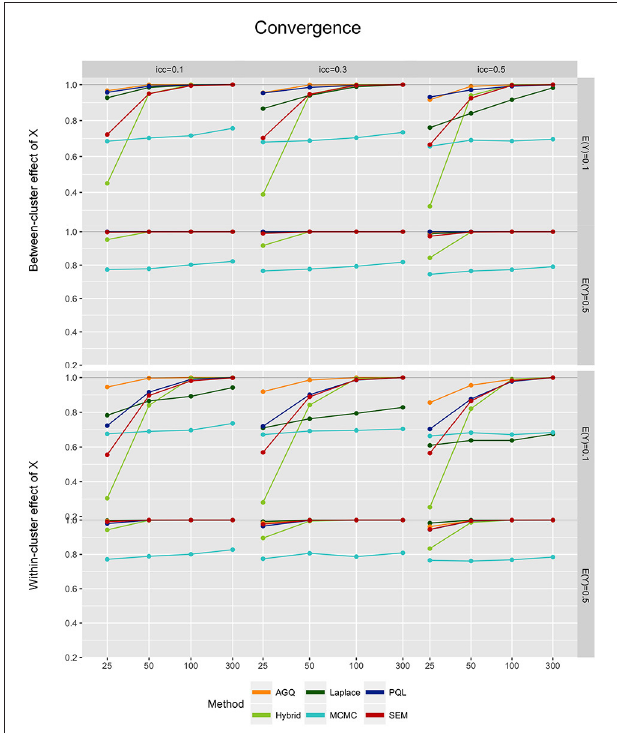
FIGURE 2 | Model convergence of the six approaches, for different measurement levels of X (within- or between clusters), outcome prevalence (0.1 and 0.5), icc l (0.1, 0.3, and 0.5), and sample size (25, 50, 100, and